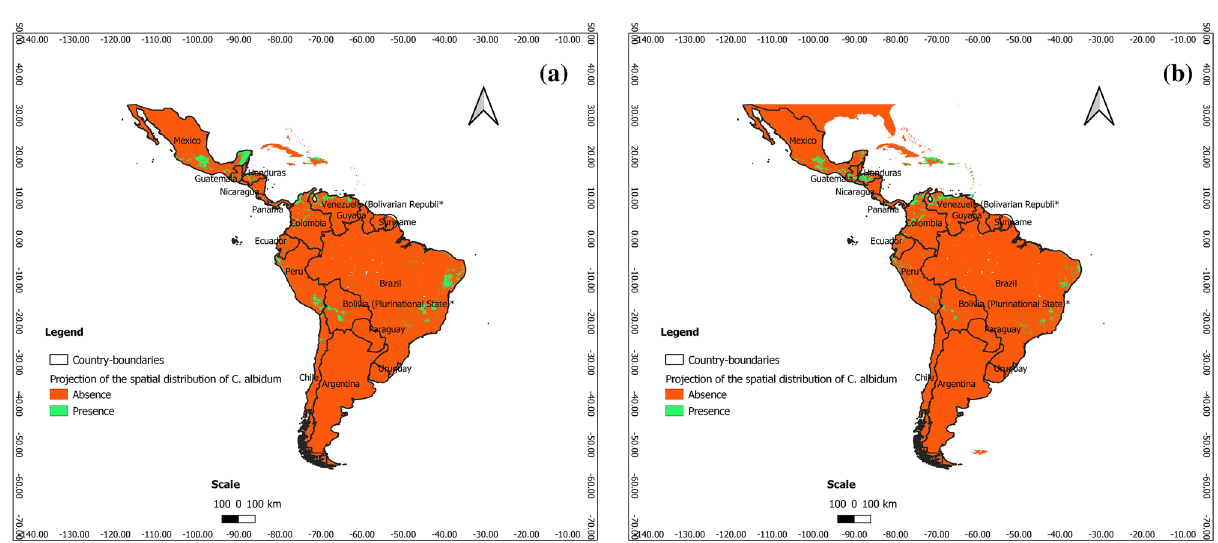
Figure 7. Projections of the spatial distribution of C . albidum according to Maxent across Latin America: a) at present; b) at horizon 2060 SSP585 (the maps were generated using R version 4.1.3 (https:// www.R- proje ct. org/), QGIS 3.18.1 (http:// qgis. osgeo. org), and WGS 84 as Coordinate Reference